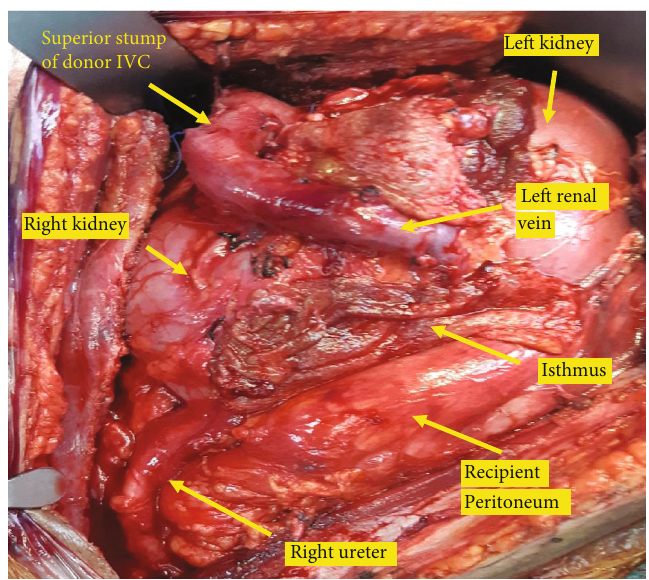
Figure 4: Anatomy of horseshoe kidney allograft in the retroperitoneal space after reperfusion.